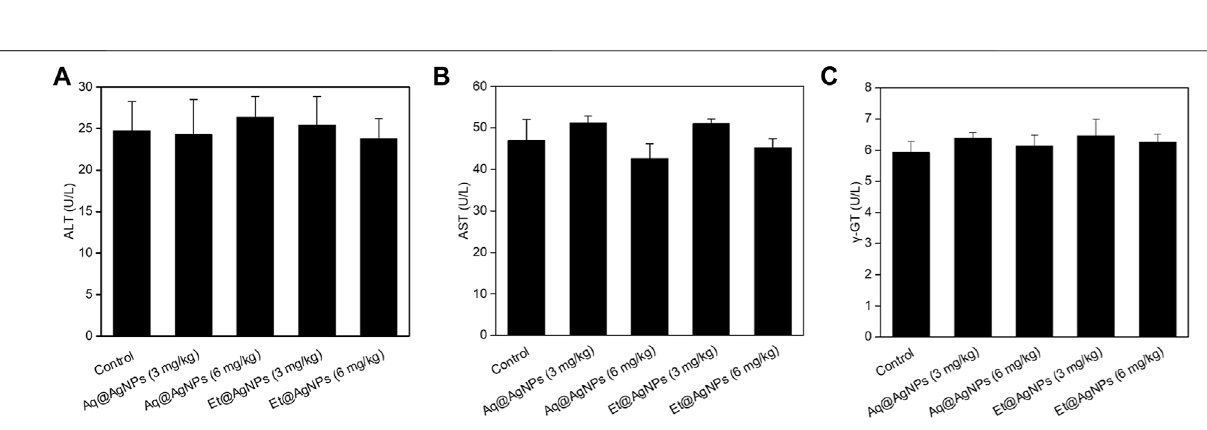
Frontiers in Nanotechnology |